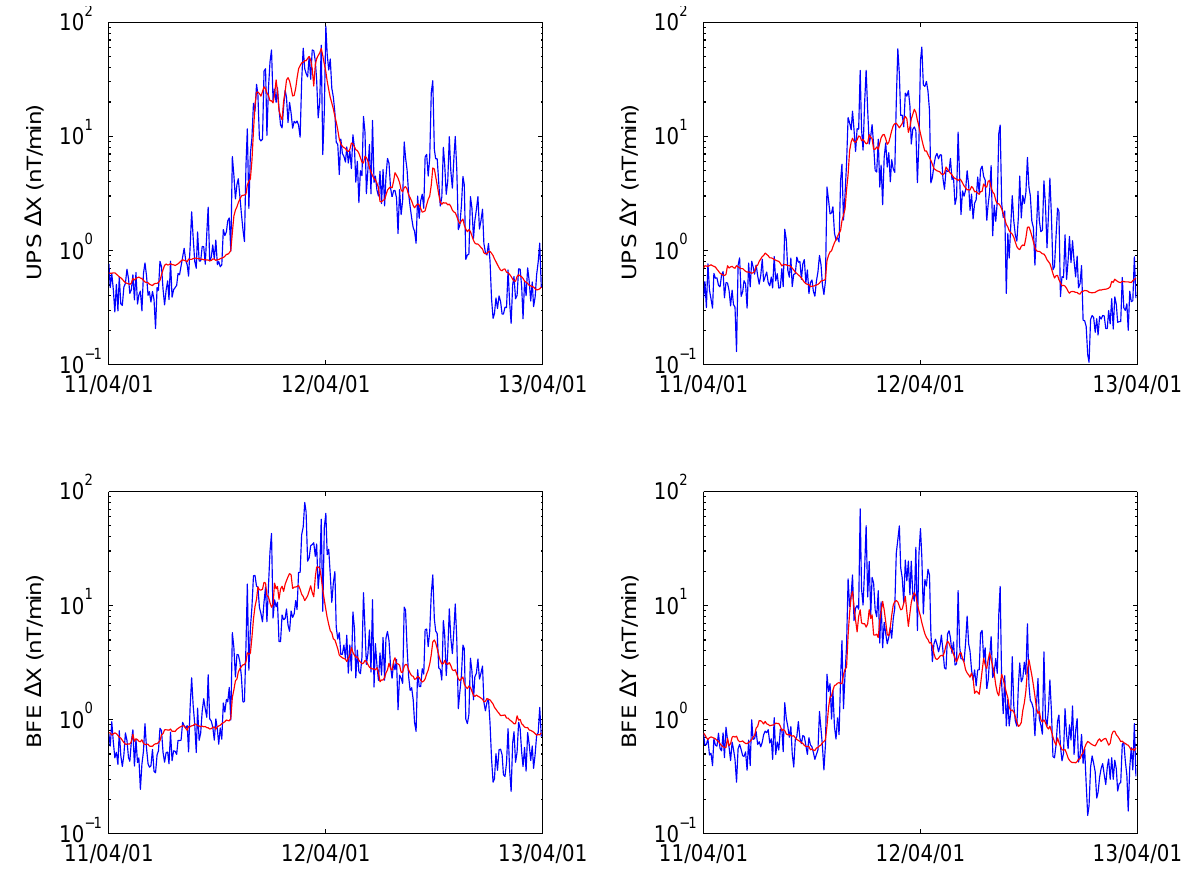
Fig. 4. The four plots show the observed (blue) and predicted (red) 10-min RMS 1X and 1Y at Uppsala (UPS) and Brorfelde (BFE) during a storm in 11–12 April 2001. The correlation in this case is around 0.90. The event was selected from the test